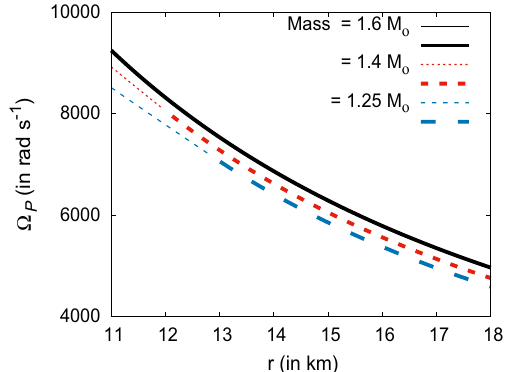
Fig. 17 Ω P of the gyro orbiting along circular geodesic around NS ( ω = 700rads − 1 )ofdifferentmass.Theblacksolidlineshowsvariation of Ω P for a 1 . 6 M ◦ star, the red short dashed and blue dashed line are for 1 . 4 M ◦ and 1 . 25 M ◦ respectively. The thicker part of each curve denotes exterior